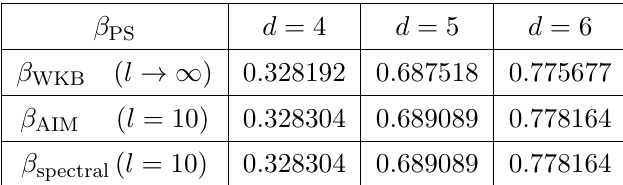
Table 2 . Comparison of (cid:12) PS obtained with WKB, AIM and a spectral method for a RNdS BH with M = 1 , (cid:3) = 3 and Q=Q max = 0 : 992. p 3 2 If we consider QNMs of the form ! = !